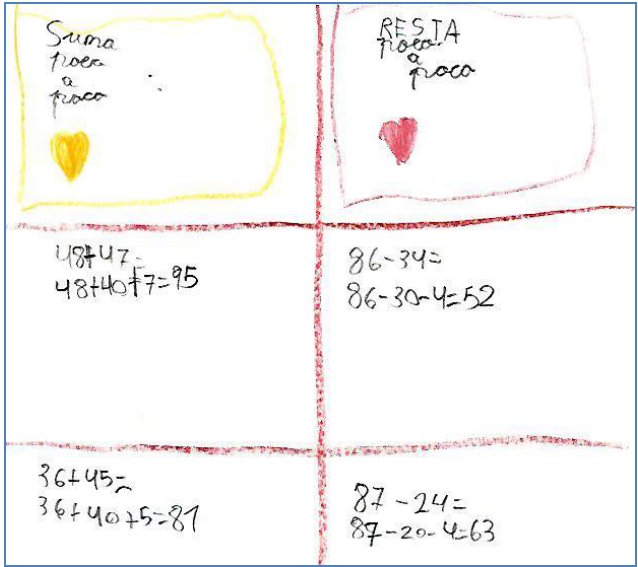
Figure 24. Add and subtract “little by